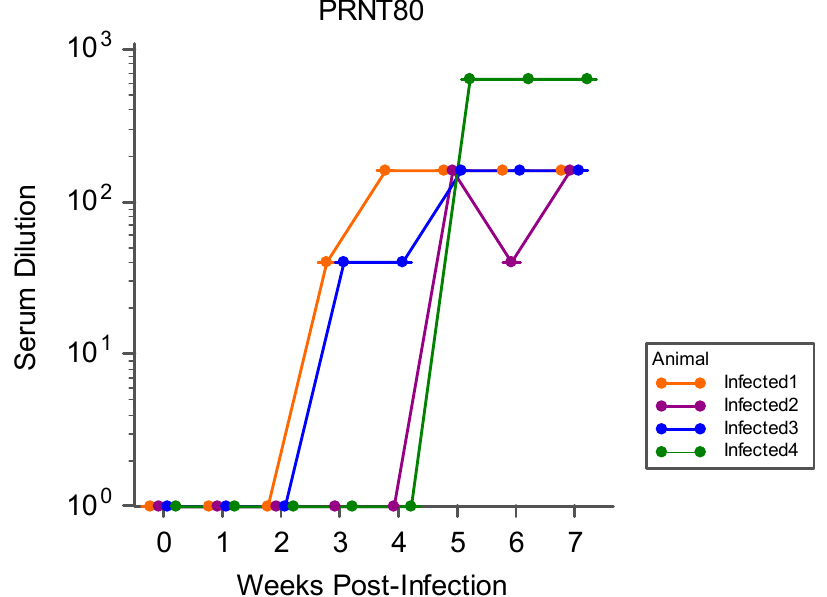
Figure 5. PRNT80 for all infected ewes during the study period, represented as the highest titer (serum dilution) to achieve ≥ 80% neutralization of viral plaque-forming units by weeks PI.